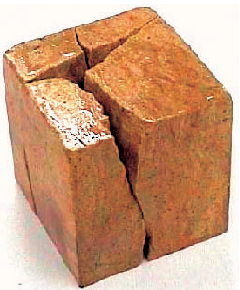
Fig. 7. Sample photo after fracture to show the fracture planes (sample: MD027).